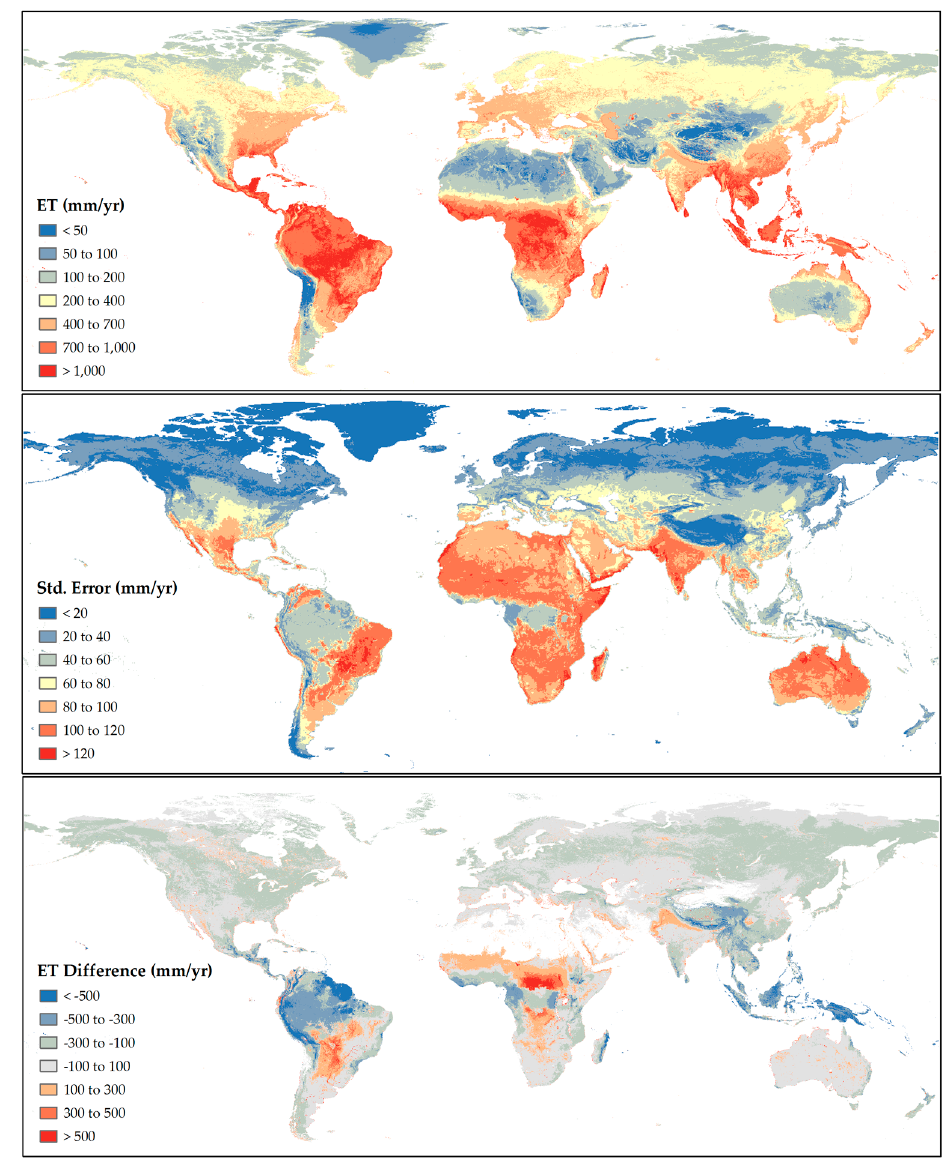
Figure 11. Mean annual ET LST estimates over the period of 2001–2013 ( top ) and corresponding standard error estimates ( middle ), and difference between top and mean annual MODIS ET MOD16 [19] for the same period ( bottom ).